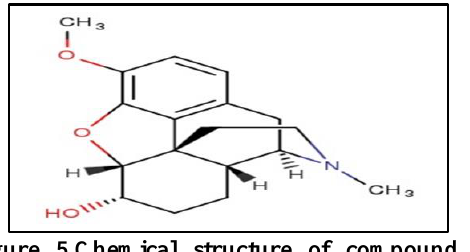
Figure 5.Chemical structure of compound a (dihydrocodeine).